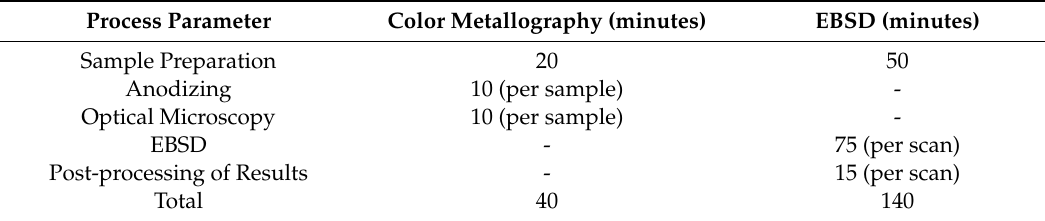
Table 1. Time consumption acquiring grain boundary data through color metallography and electron backscatter di ff raction